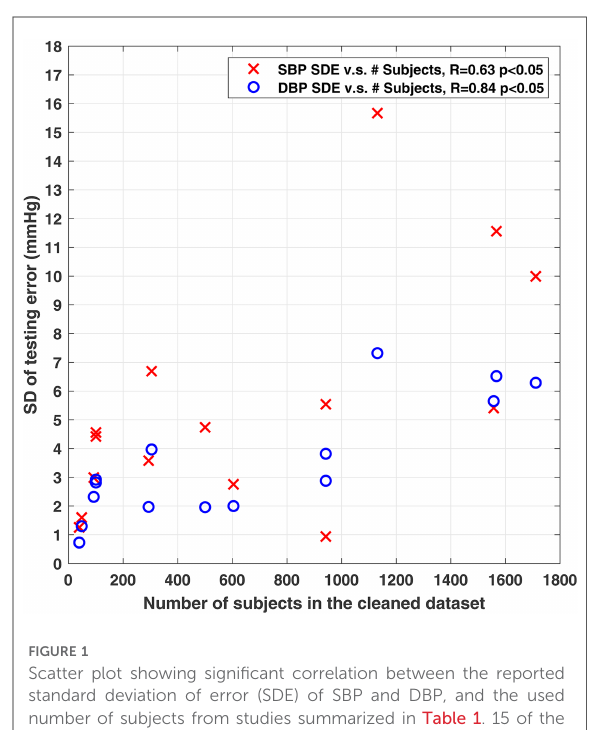
FIGURE 1 Scatter plot showing signi fi cant correlation between the reported standard deviation of error (SDE) of SBP and DBP, and the used number of subjects from studies summarized in Table 1 . 15 of the 17 studies in Table 1 with reported number of subjects and SDE were included